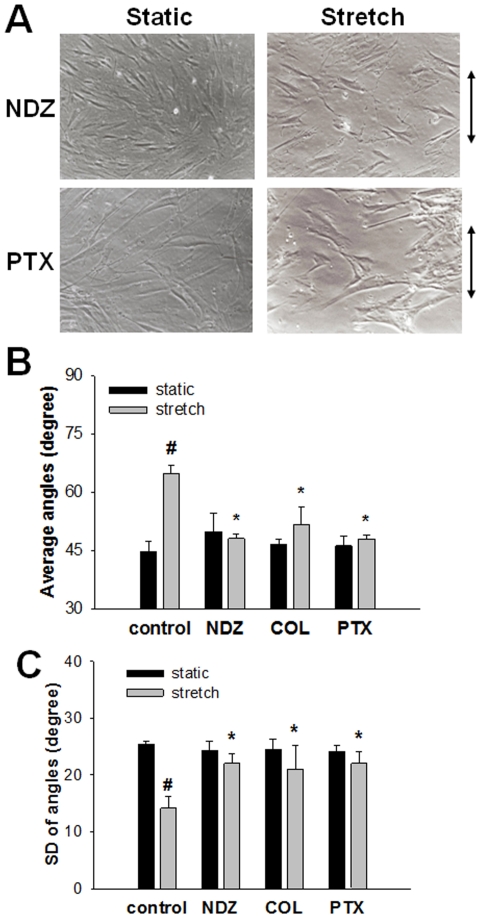
Roles of microtubules in stretch-induced cell reorientation.Cyclic stretch (20%, 2 h) was applied to the cells after pretreatment with either 1 µM nocodazole (NDZ), 10 µM colchicine (COL), or 1 µM paclitaxel (PTX). (A) Representative phase-contrast images of the static (left panels) and stretched (right panels) cells pretreated with either 1 µM nocodazole (NDZ) (upper panels) or 1 µM paclitaxel (PTX) (lower panels). Average (B) and SDs (C) of angles of the cell orientation. Bar graphs represent means ± SD (n = 4). *: Significantly different (P<0.05) from the value with cyclic stretch. #: Significantly different (P<0.05) from the value with unstretched control.